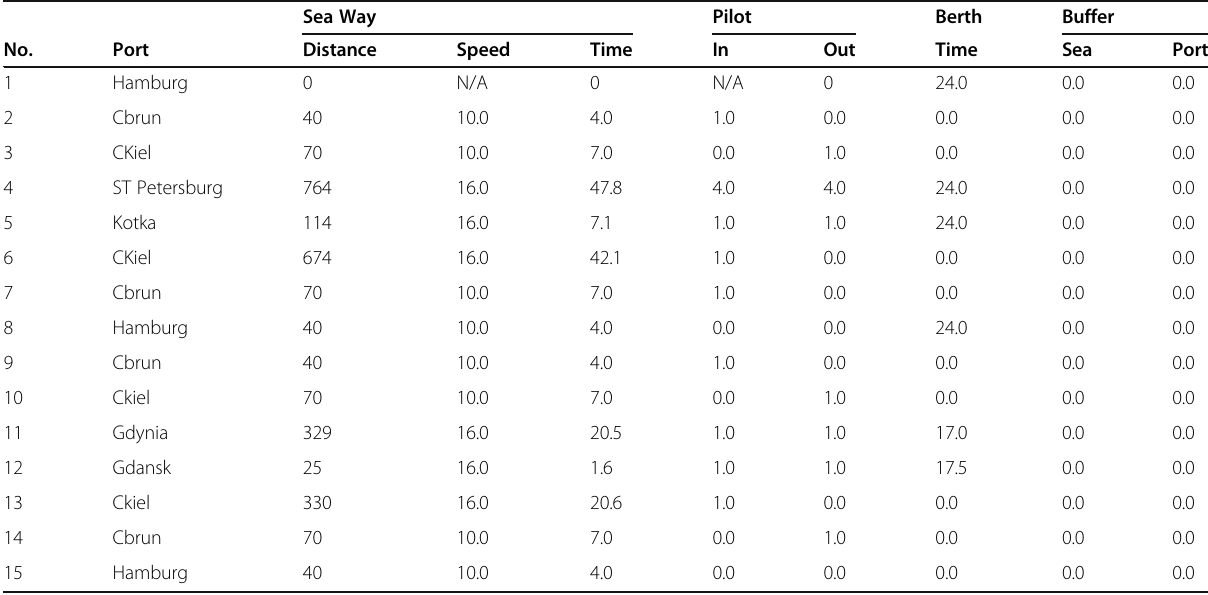
Table 5 Alternatives to connect Kotka with Russia and Poland (Source: authors) Sea